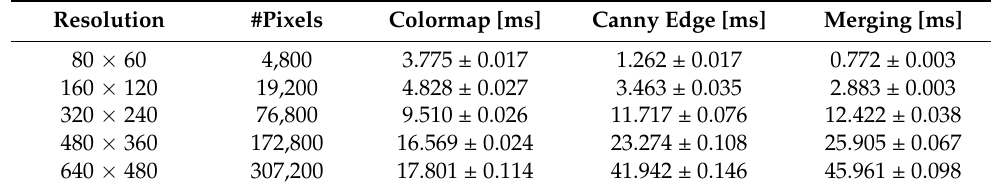
Table 6. Timing (in ms) for different operations on the CPU based on the supported resolutions together with the confidence